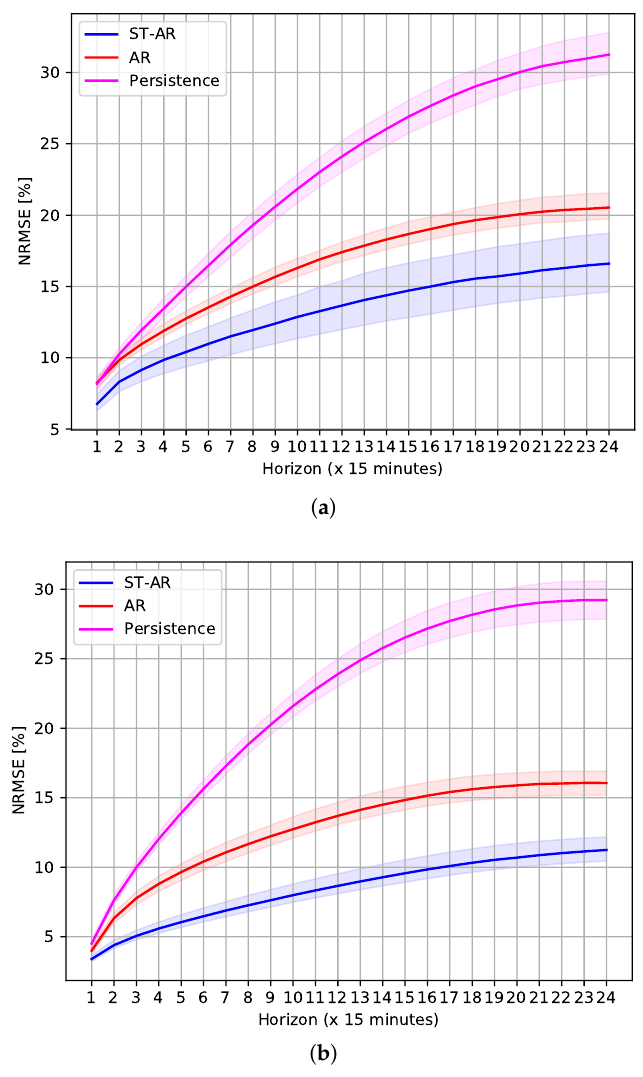
Figure 8. Comparison between spatio-temporal autoregressive (ST-AR), single autoregressive (AR) and persistence models. ( a ) Forecast NRMSE for the real dataset. ( b ) Forecast NRMSE for the synthetic dataset. The forecast horizon is six hours in steps of 15 min. Solid lines show the median error while the shaded areas show the inter-quantile distance of the